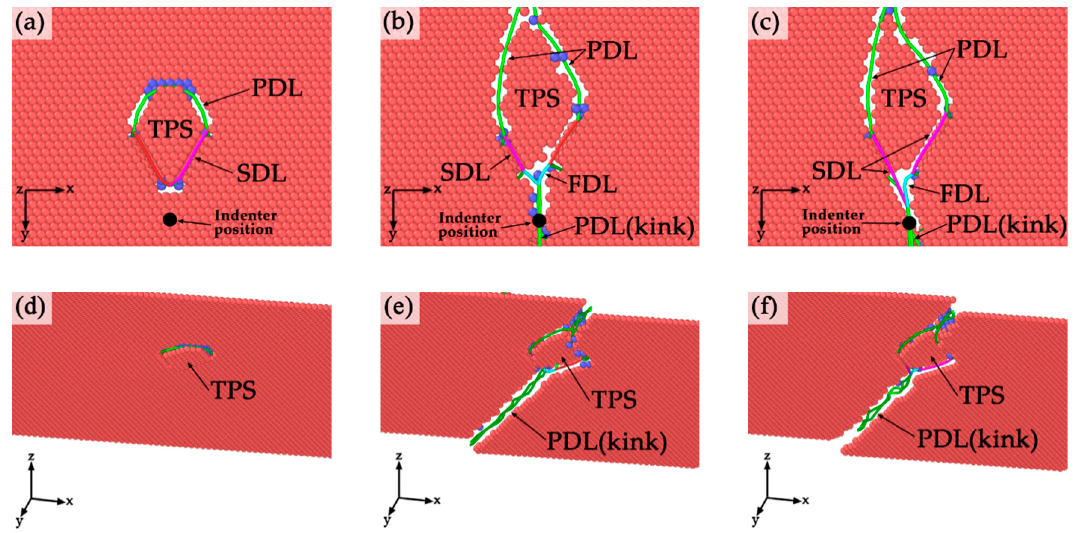
Figure 8. Twinning partial slips on the upper twin boundaries in TPT, SDT, and TDT in bottom view and bottom side views. The indenter depth of these figures is d = 5.0 Å. ( a – c ) Bottom view in TPT, SDT, and TDT; ( d – f ) Bottom side view in TPT, SDT, and TDT.